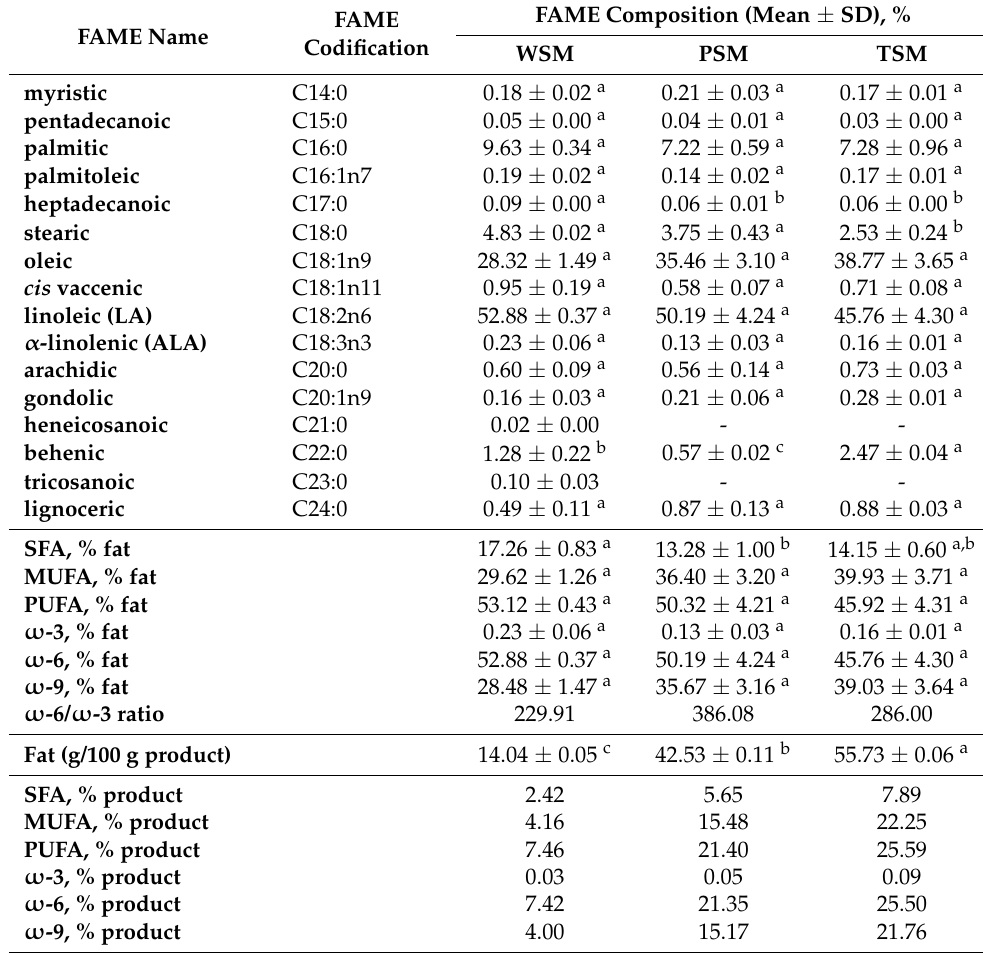
Table 2. Fatty acid methyl esters content of meal samples